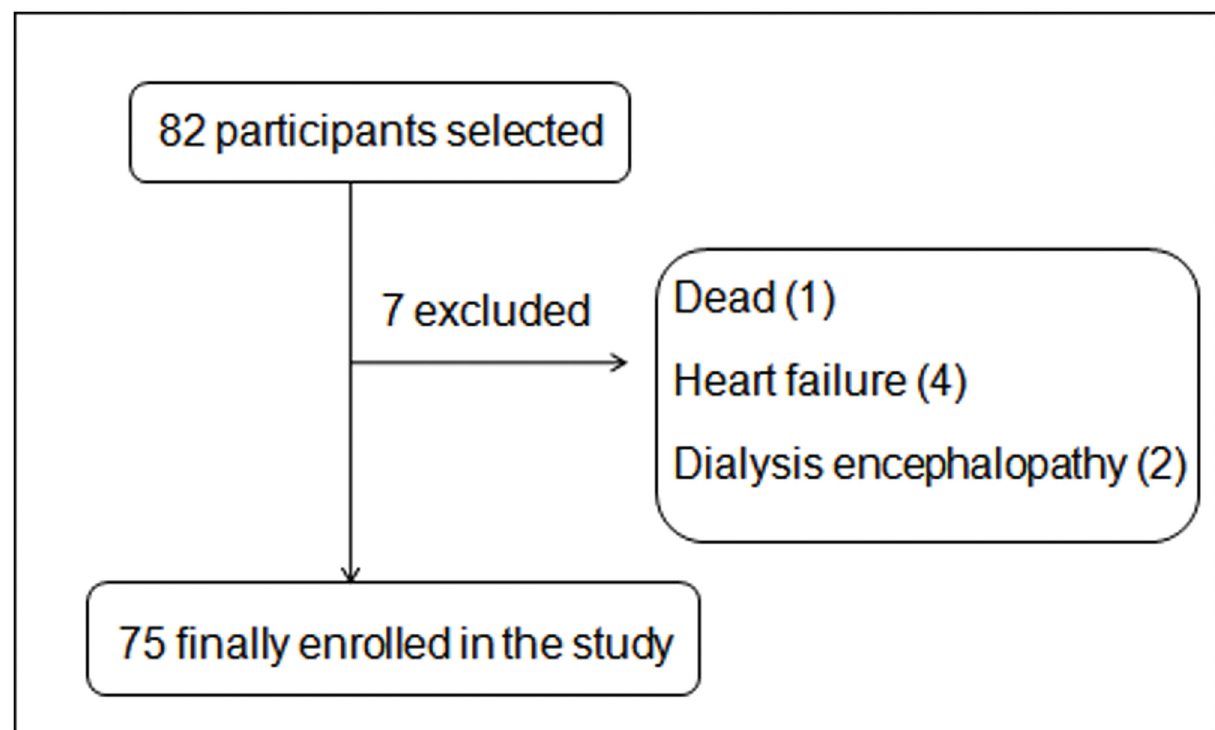
Figure 1. A flow chart of selection. doi: